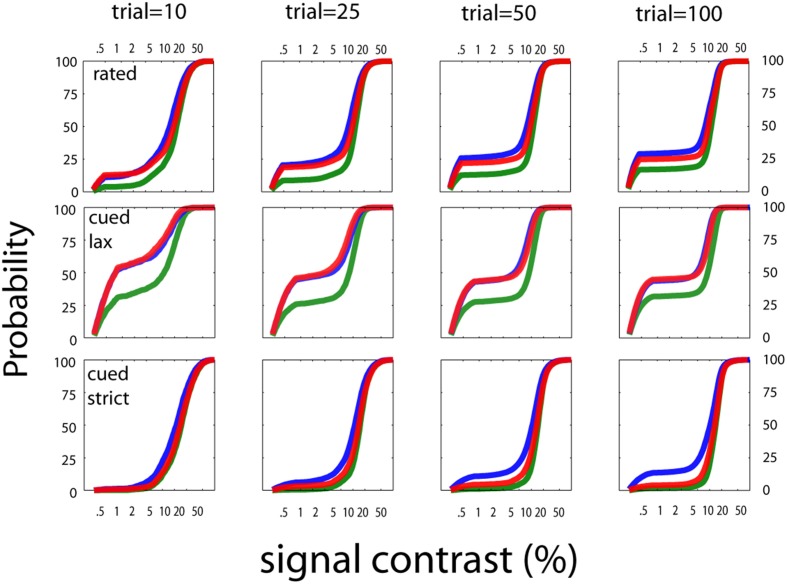
Stimulus sampling patterns for cued and rated detection. The stimulus sampling patterns of the qYNC and qYNR methods are presented for stopping points of 10, 25, 50, and 100 completed trials. The general pattern is similar to that demonstrated by the quick YN method; namely, that stimulus sampling is (1) mostly focused to the dynamic region(s) the psychometric function(s), and (2) increased at the lowest-intensity stimuli for liberal response states. This sampling strategy allows the concurrent estimation of sensitivity and decision parameters in an efficient way.